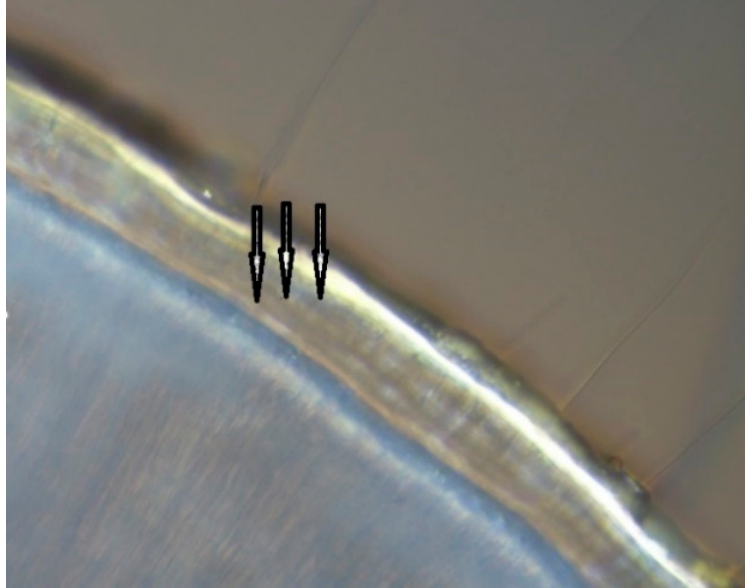
Figure 2. Saw sections (70–100 µm) of canine teeth of mink 2 and 3 mm from the apex under a microscope in reflected light differential interference contrast (DIC) microscopy. Three dark incremental lines (arrows) are visible.